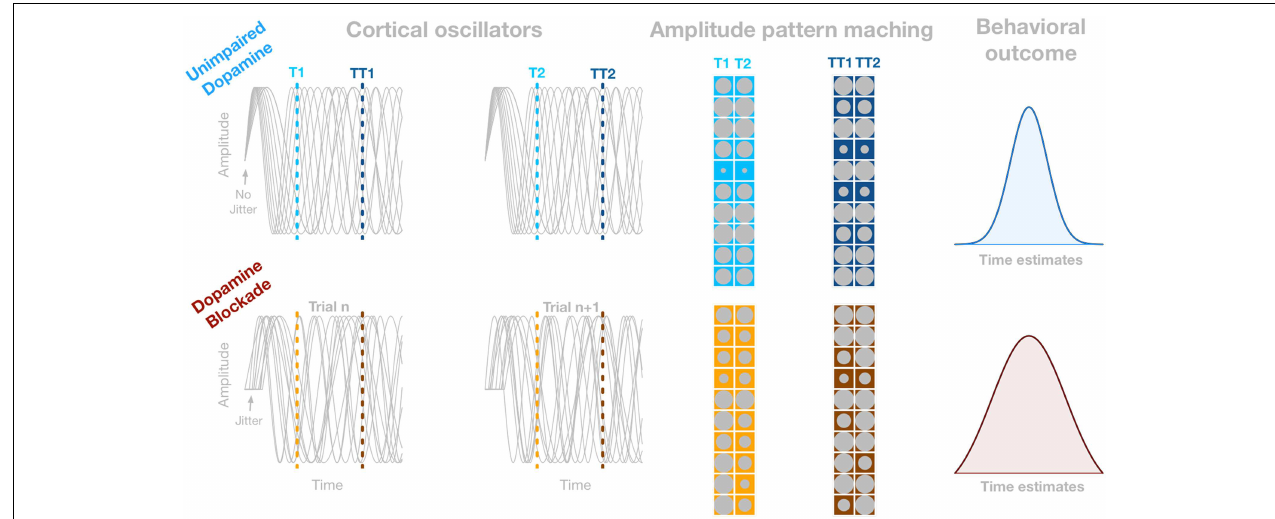
n, and n + 1 trial, respectively. Both matrices in each row depict the amplitude pattern at 200, and 450ms that correspond to the dotted lines in the panels showing the oscillators. The amplitude/phase pattern between trials (columns of each matrix) is more dissimilar in the second row, because of the larger variability in the onset of the oscillators. Thus, if a particular amplitude/phase pattern has to be detected, the detection process will be more variable, causing larger variability in the state of oscillators around the criterion time. The right column depicts the spread of time estimations caused by jitter in the reset latency of ongoing oscillatory